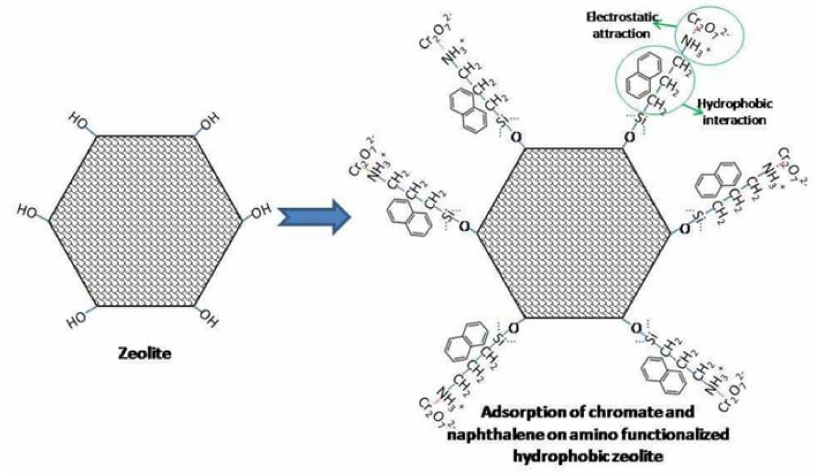
Figure 3. Schematic diagram of the modification of natural zeolite and the adsorption process of on chromate and Nap on the amino functionalized hydrophobic